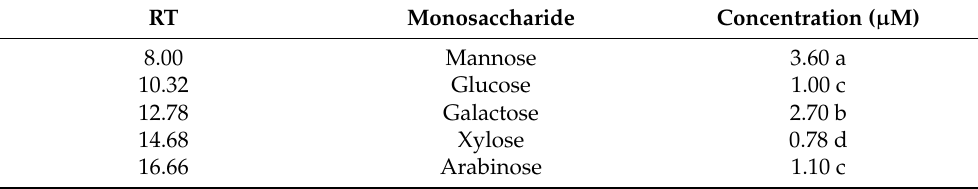
Figure 7. Chromatograms for analysis of the component monosaccharide present in polysaccharide Delonix regia using the pre-column PMP derivatization HPLC method. Table 2. Monosaccharide profile of isolated DR polysaccharides detected by